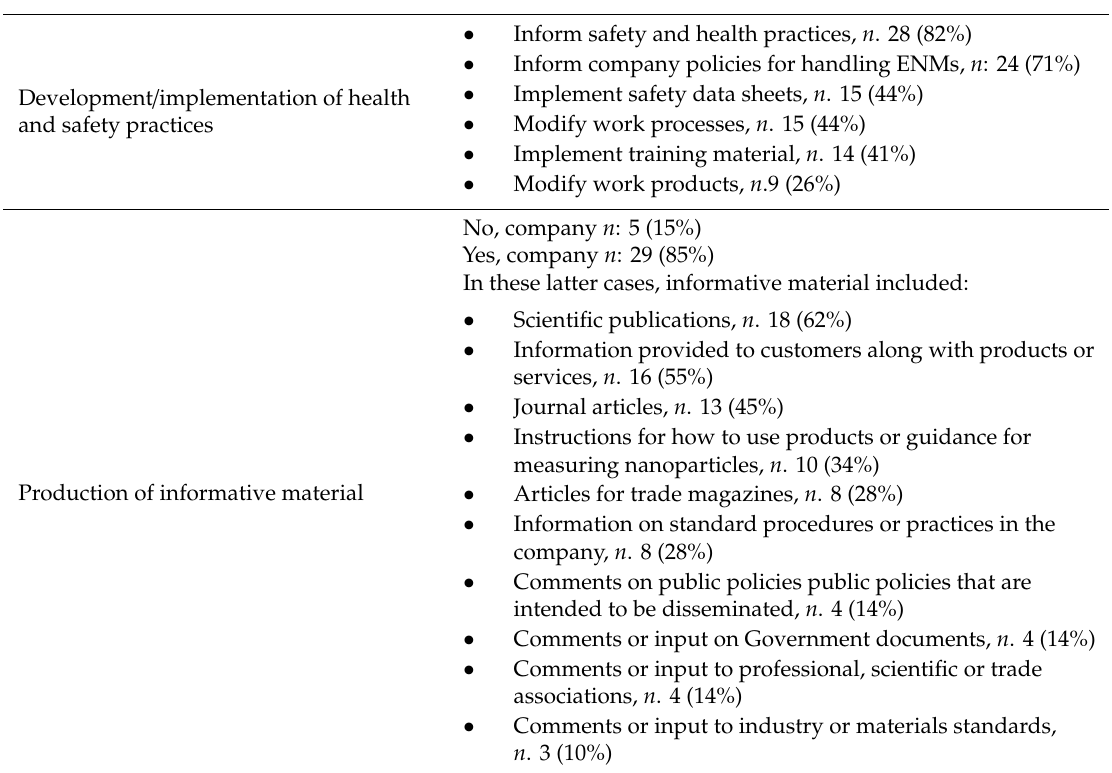
Table 2. Summary of the changes introduced in health and safety policies according to NM risk awareness (n., number of respondent companies and relative percentages of the total survey